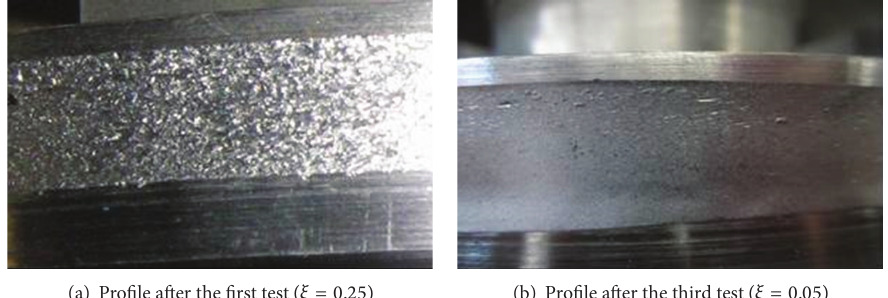
Figure 11: Different wear regimes on the wheel